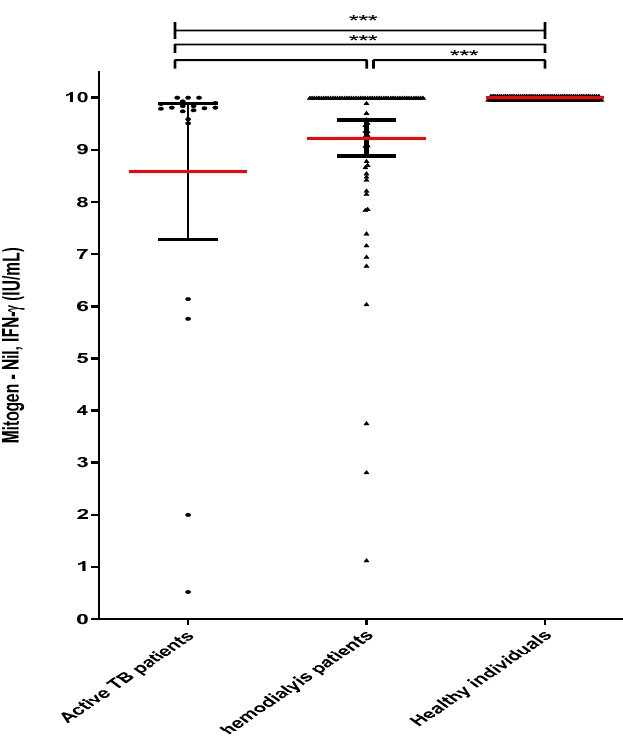
Figure 2. PHA-stimulated IFN- γ levels in hemodialysis patients and healthy individuals. Note: Whole blood of study subjects (active TB patients group, hemodialysis patients (HD) group, and healthy individuals (HI) group) were stimulated with Phytohemagglutinin A for 24 h; The red line in the graph represents the mean value for each group; *** p < 0.001. Table 3. Comparison of IFN- γ production TB antigen stimulated.